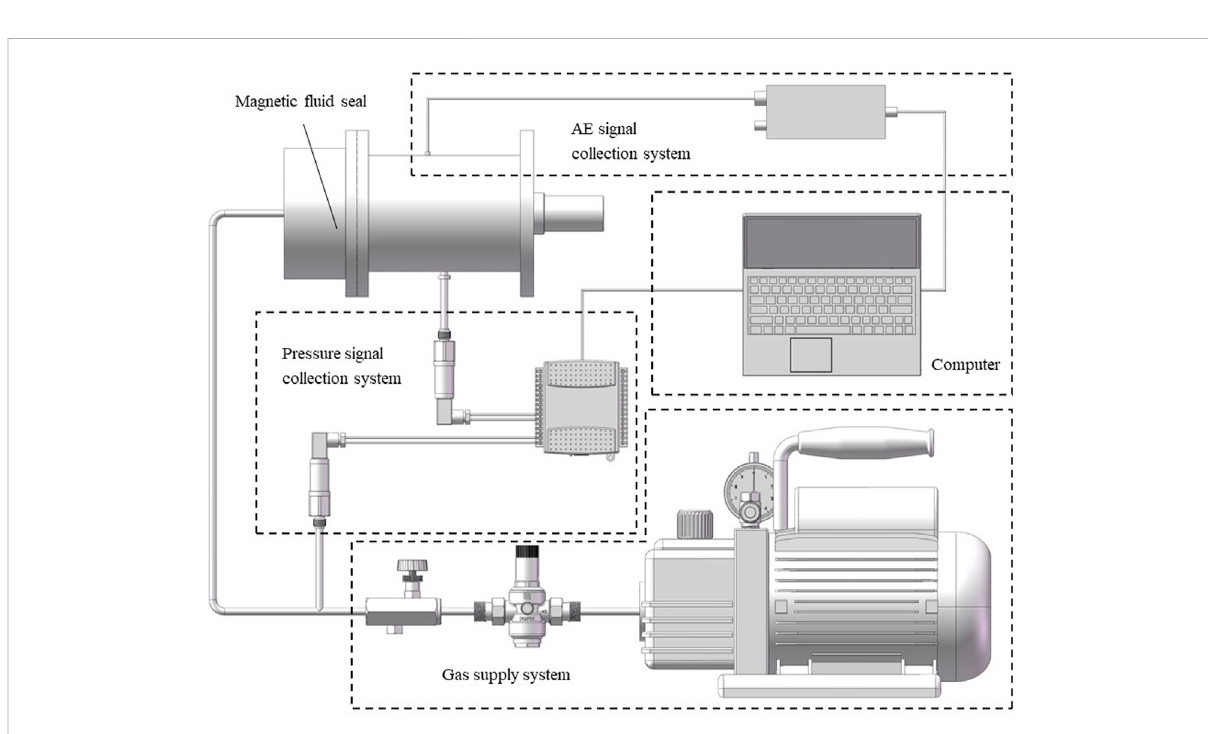
FIGURE 3 Schematic diagram of the experimental